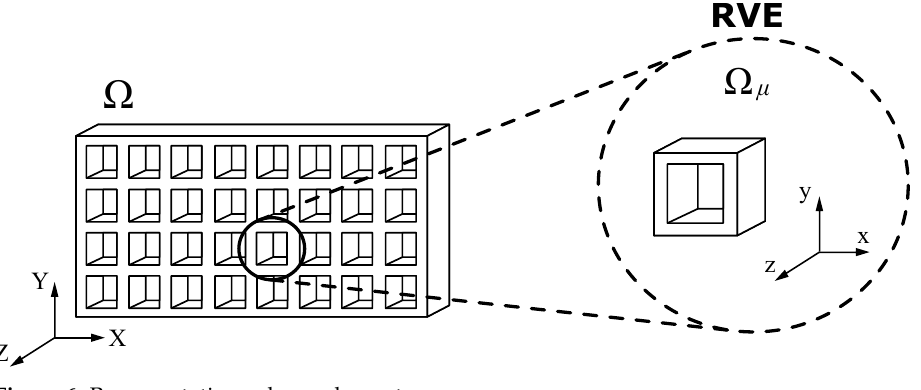
Figure 6. Representative volume